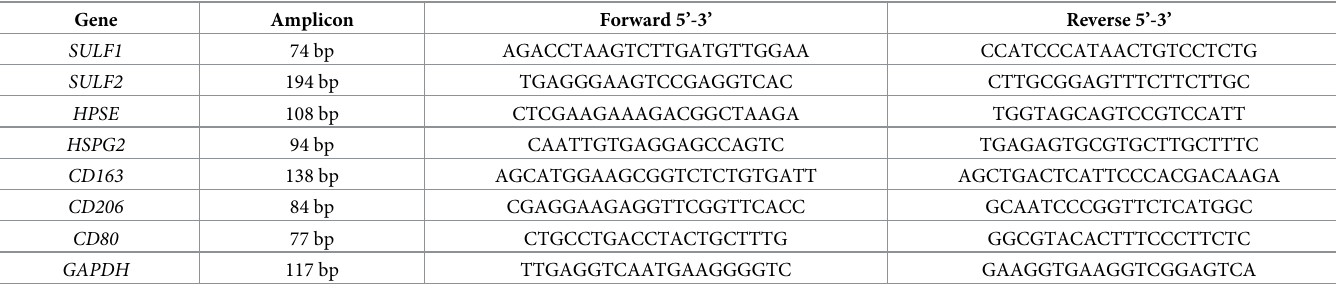
Table 1. Primers used for qRT-PCR